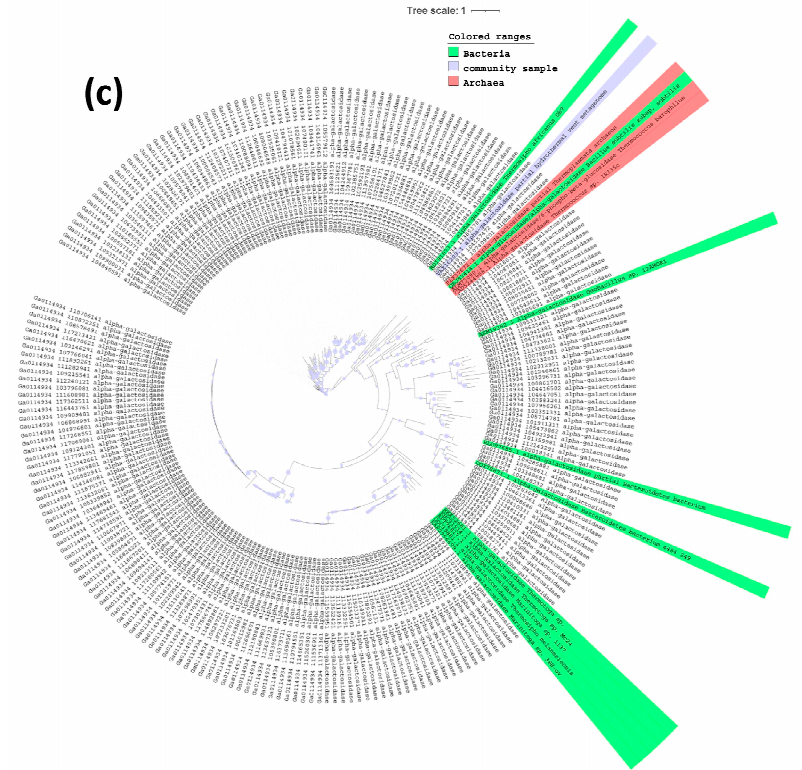
3 Figure 3. Phylogenetic maximum-likelihood tree based on partial sequences of ( a ) endoglucanase, ( b ) beta-glucosidase and ( c ) alpha-galactosidase amino acid sequences of the WH2 metagenome. Reference sequences from various microbial species and other metagenomes that were retrieved from Genbank are also included. The branches denoting sequences derived from GenBank were colored on the taxonomy domain they are coming from—i.e., green for bacteria, red for archaea and blue for community samples. Scale bar represents 1 amino acid substitution per 100. Dots on the branches represent bootstrap support values. The larger the dots, the higher the bootstrap values (close to